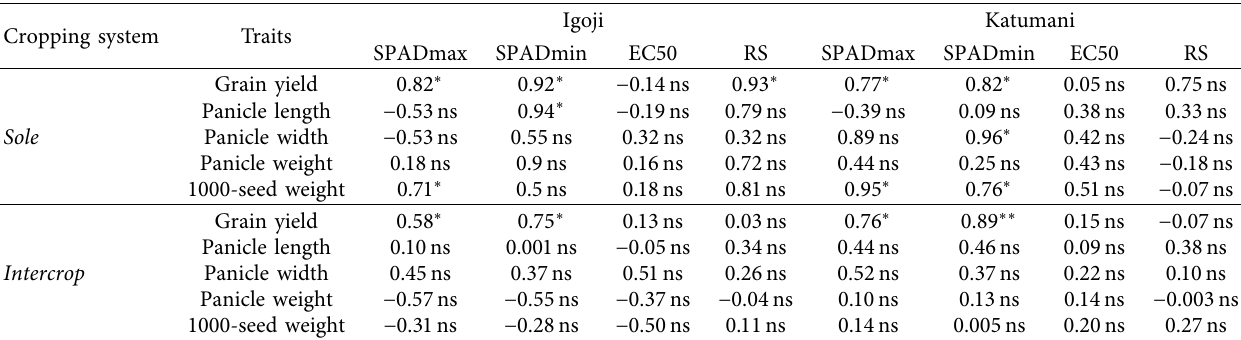
Table 3: Correlation coefficients between senescence traits and sorghum grain yield and yield parameters of two sorghum varieties (Gadam and Serena) grown in an intercrop system with two varieties of cowpea (K80 and M66) at 0, 40, and 80kg · N · ha − 1 during 2018/2019 short rains at the KALRO research stations in Igoji and Katumani during the 2018/2019 short rain season. Cropping system